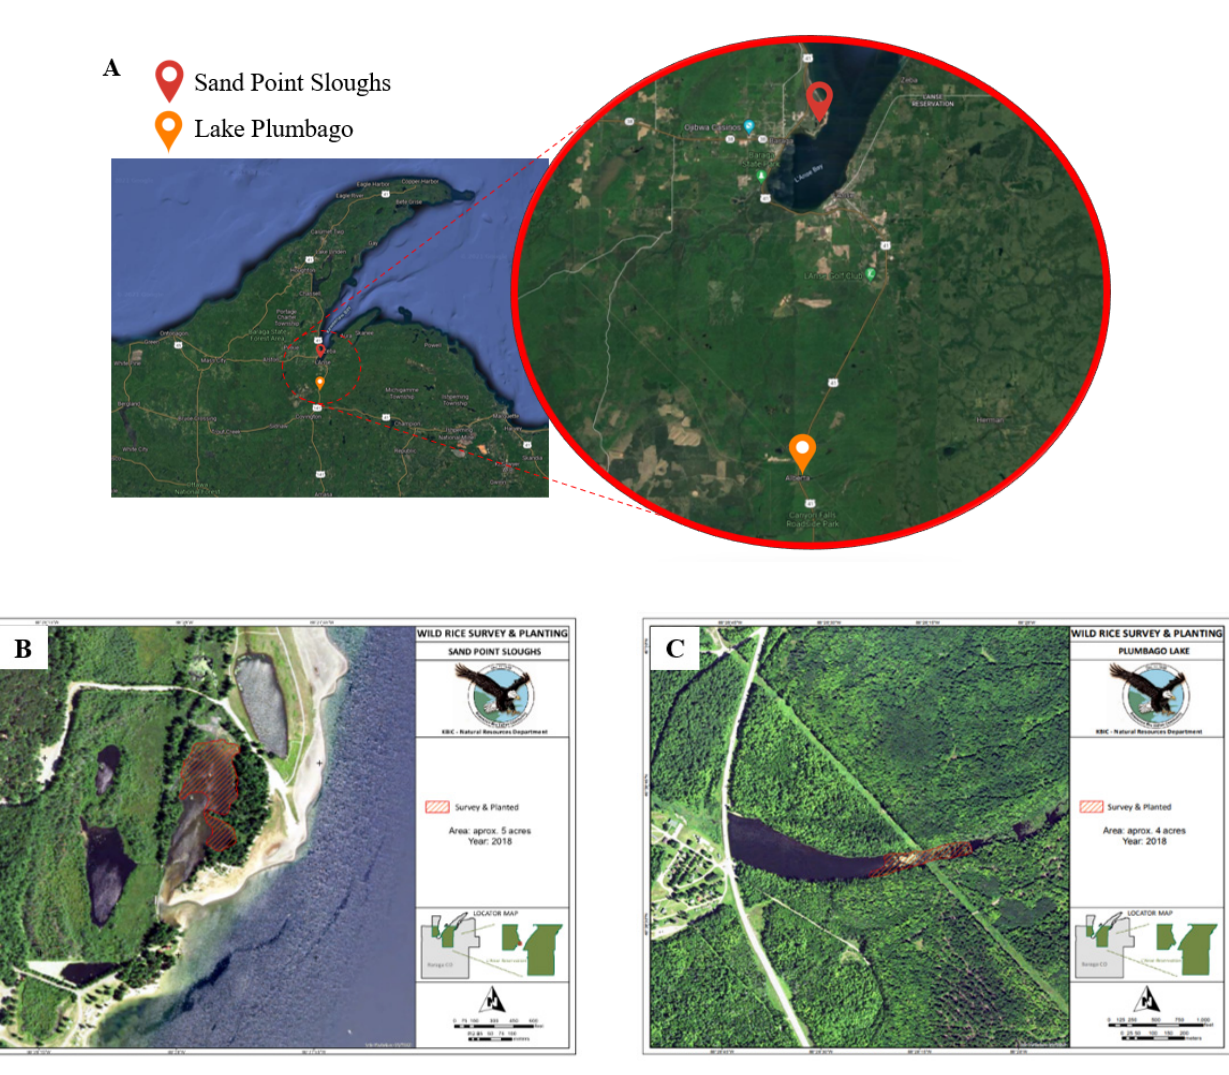
Figure 1. Sampling locations of Sand Point sloughs and Lake Plumbago in Michigan (Google Maps, retrieved July 2021). ( A ). Locations of Sand Point sloughs and Lake Plumbago, ( B ). Specific sampling area at Sand Point sloughs, ( C). Specific sampling area at Lake Plumbago.